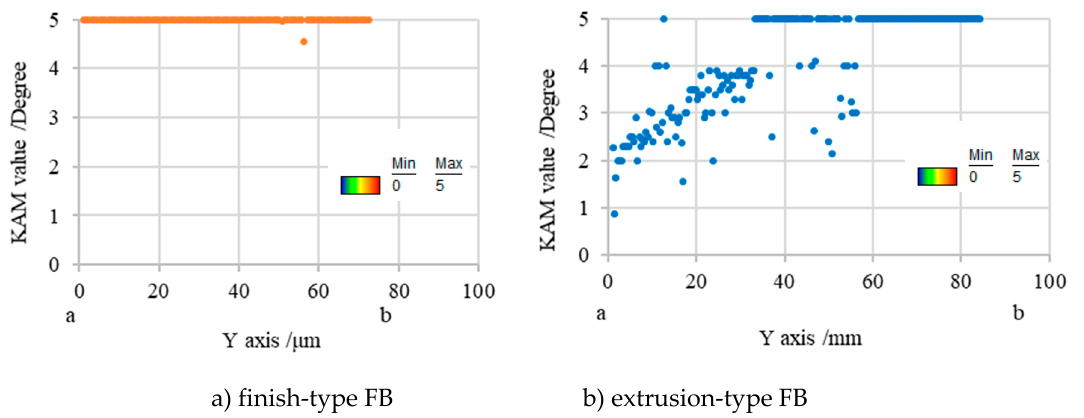
Figure 10. Comparison of phase map for 60% t punch penetration between finish-type FB and extrusion-type FB: ( a ) finish-type FB; ( b ) extrusion-type FB.